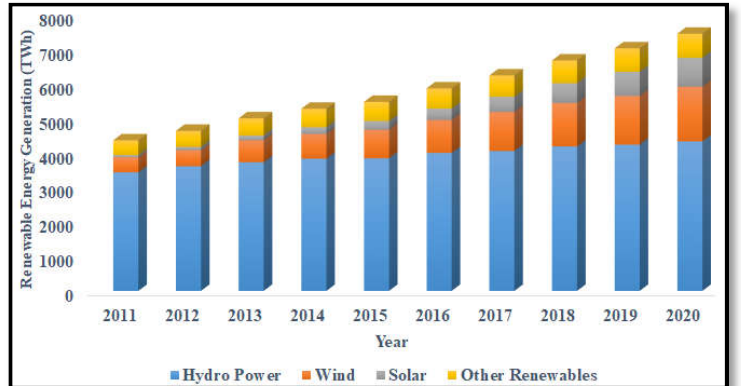
Figure 4. Hybrid renewable energy generation. ( Source: Statistical review of world energy).